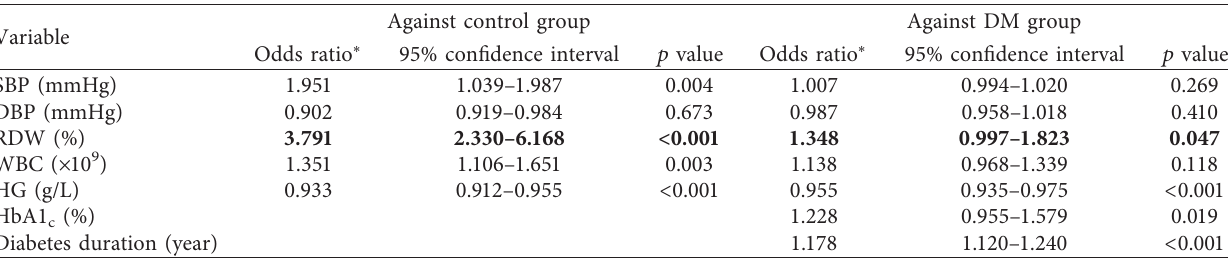
Table 4: Logistic regression models evaluating the risk factors in